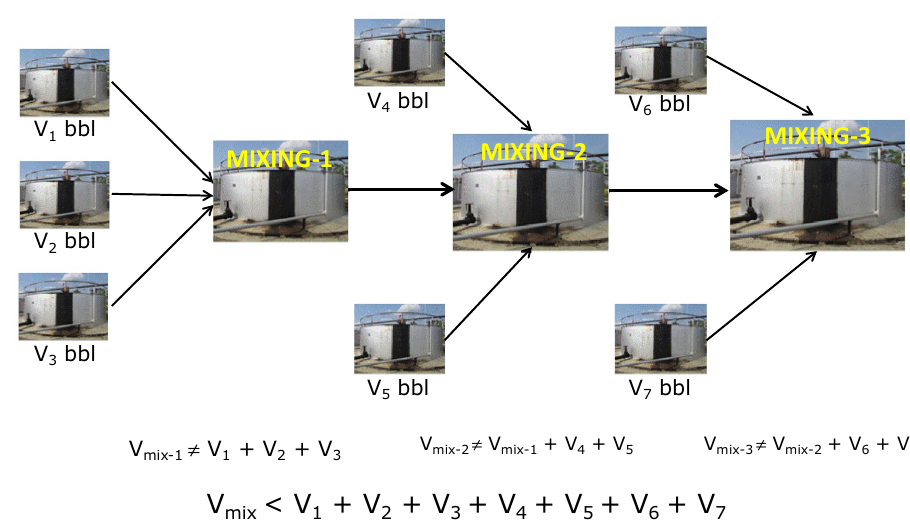
Fig. 1 Typical oil mixing phe- nomena in gathering